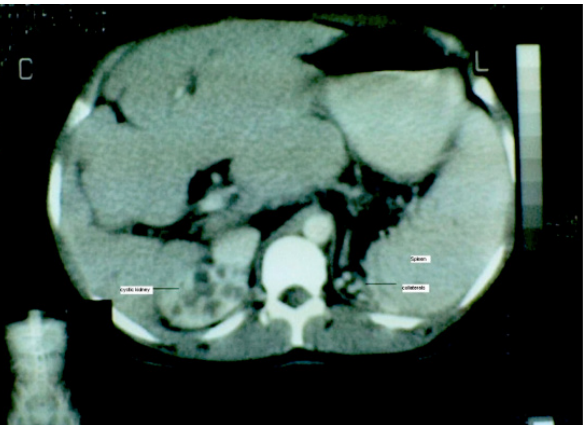
Figure 1: CT scan of upper abdomen of patient showing enlarged liv- er and spleen with polycystic kidneys. There are multiple collaterals in left paravertebral region